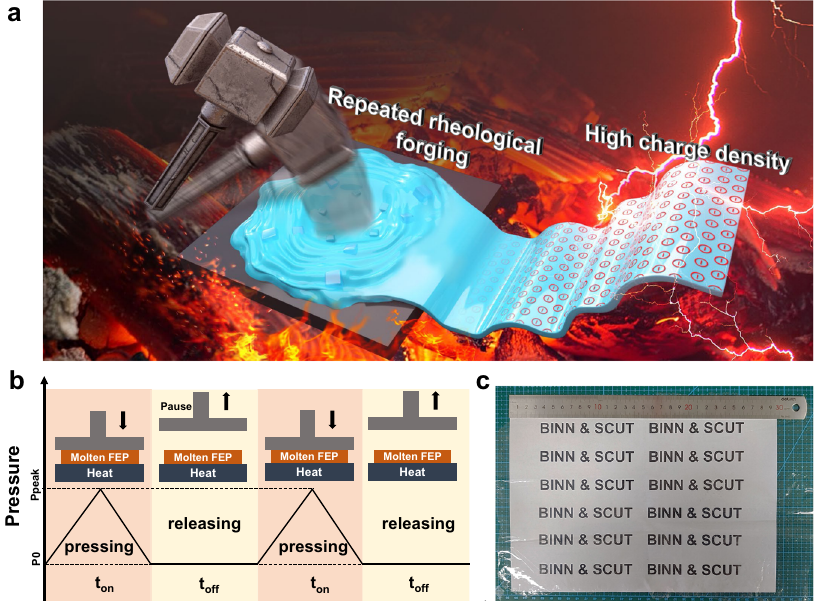
Fig. 1 Repeated rheological forging technique and molding fi lm. a Production of high triboelectric charge density fi lms by rheological repeated forging technique. b Illustration of Repeated rheological forging technique. c Physical map of FEP fi lm produced by RRF